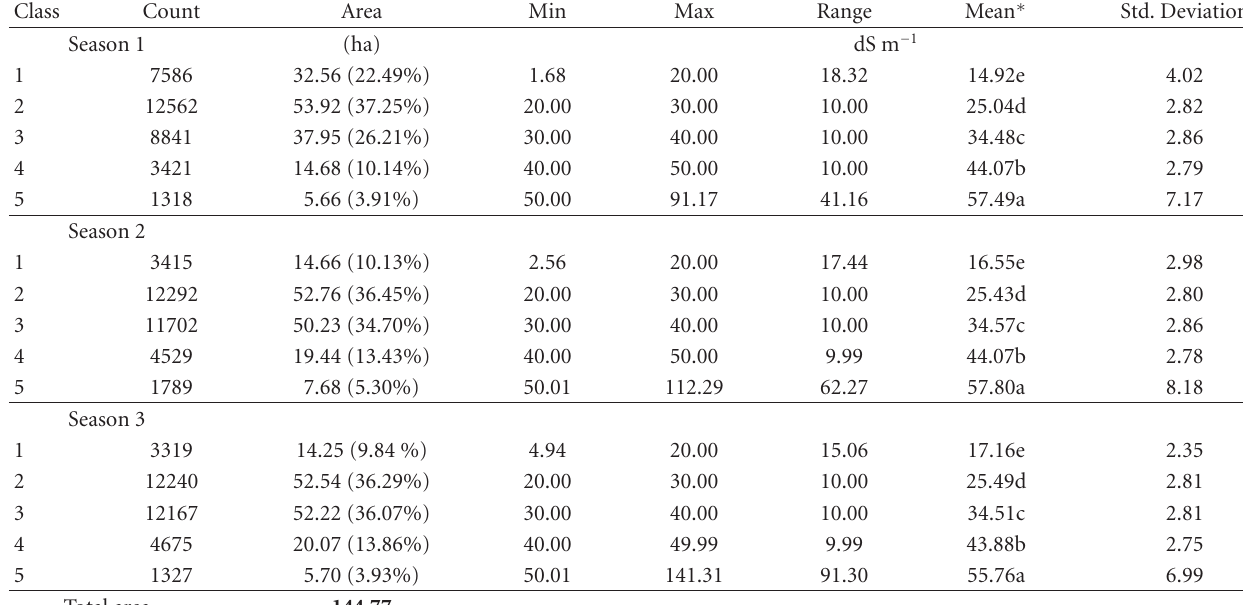
Table 1: Summary of kriged shallow EC a maps for three seasons classified by smart quantiles.